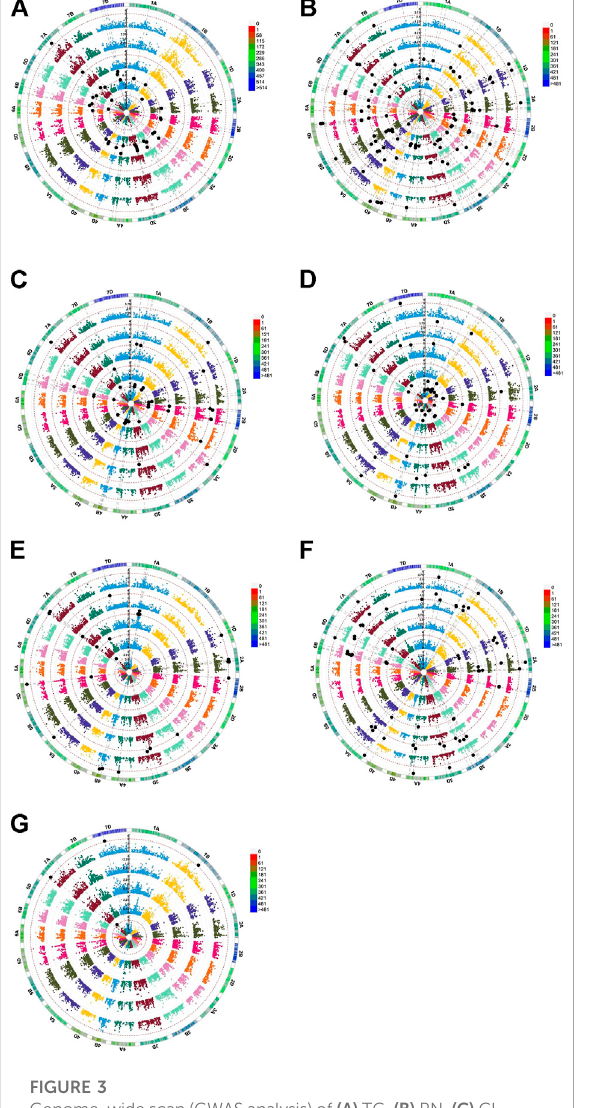
TABLE 2 Chromosome-wide distributions of markers associated with varioustraits at p < 1× 10 − 3 (normaltext) and p < 1.452 × 10 − 4 (bold